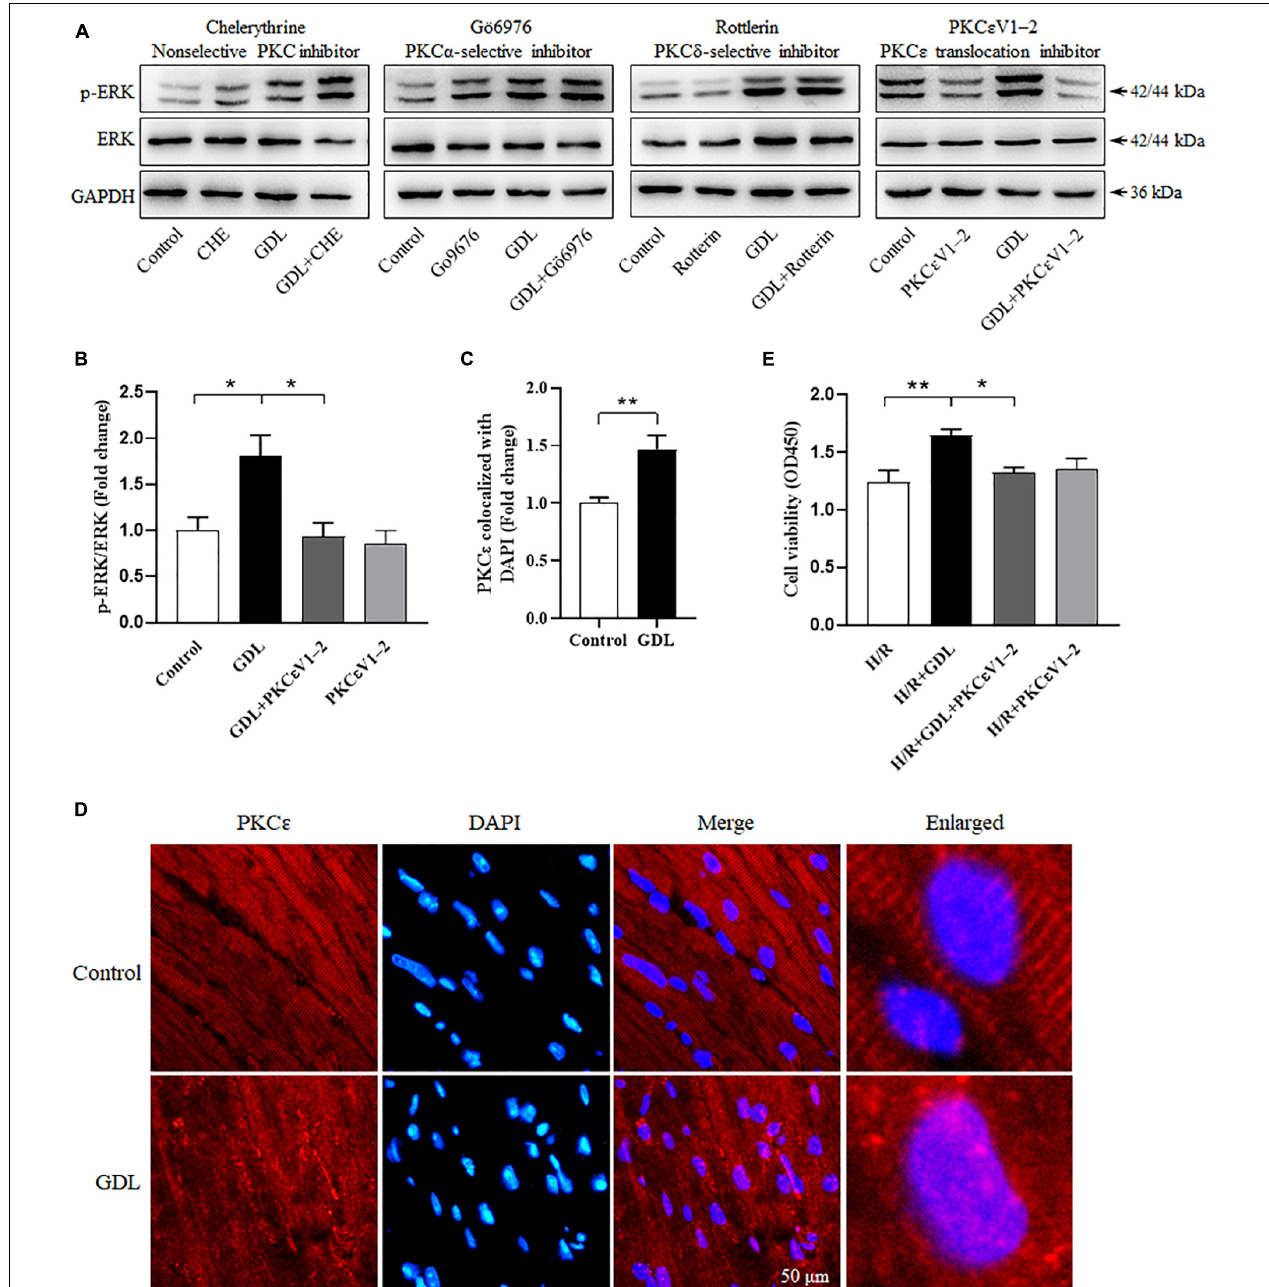
FIGURE 7 | Protein kinase C isoform PKC ε is identified as the direct target of GDL by functional analysis. (A) Representative Western blot images of ERK expression and phosphorylation in H/R-injured NRCM cells following the treatment of PKC inhibitors (Chelerythrine, Gö6976, Rottlerin or PKC ε V1-2). (B) Quantification analysis of ERK phosphorylation in H/R-injured NRCM cells following PKC ε V1-2 treatment. (C,D) Immunofluorescence staining of PKC ε nuclear translocation in the heart of mice treated with or without GDL. (E) The effect of PKC ε V1-2 on GDL-induced cardioprotection against H/R injury. * P < 0.05 and ** P < 0.01 between indicated groups. Data shown are representive of five independent